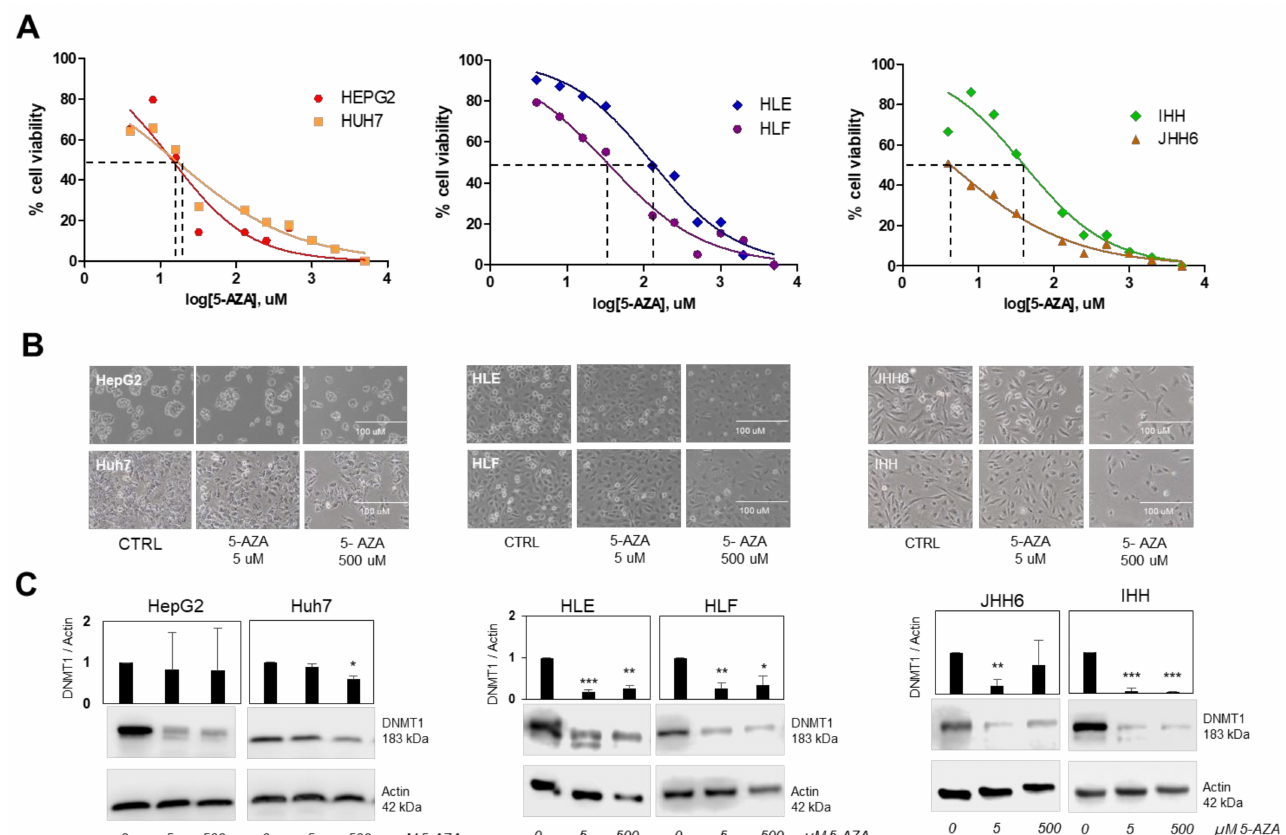
5-AZA was chosen as a demethylating drug. First, we evaluated 5-AZA cytotoxicity by MTT test to determine the non-lethal concentration 50 (LC 50 ), ranging from 2 µ M to 5 mM. Upon 5-AZA treatment for 24 h, the calculated LC 50 was 128 µ M for HLE, 33 µ M for